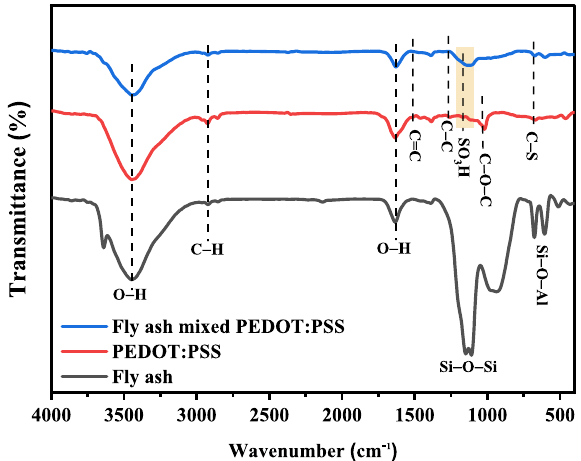
Figure 4. FTIR spectra of fly ash annealed at 80 °C, PEDOT:PSS, and fly ash mixed with PEDOT:PSS